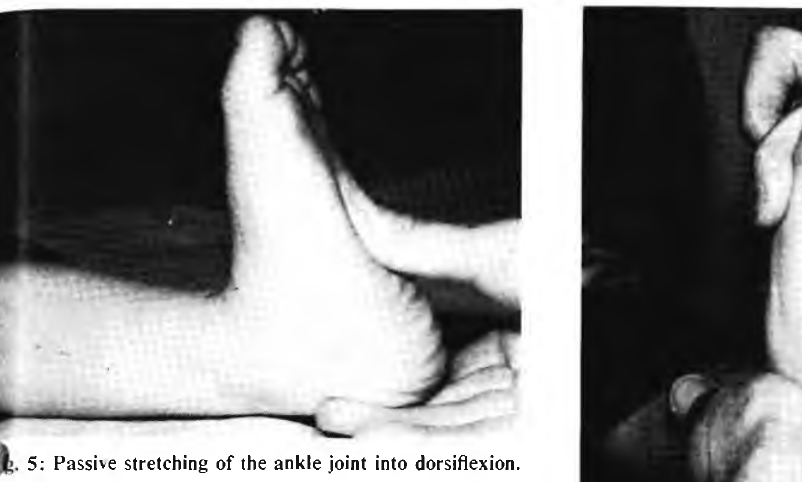
6 : Passive stretching of the forefoot into